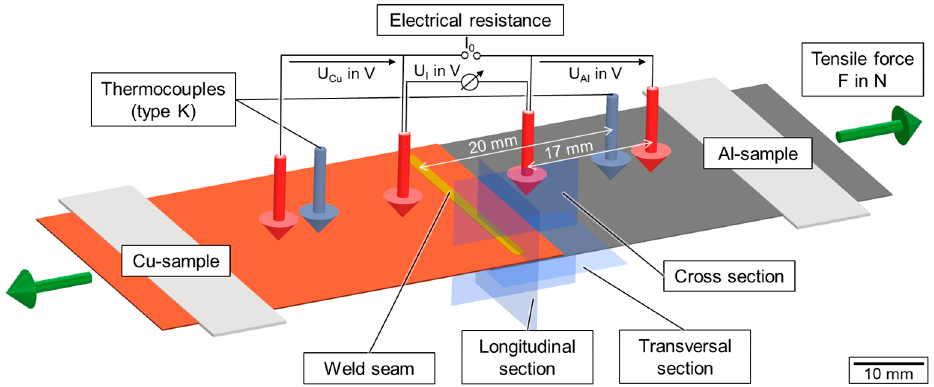
Figure 4. Schematic representation of the analyses carried out on the welded samples within the scope of the investigations.